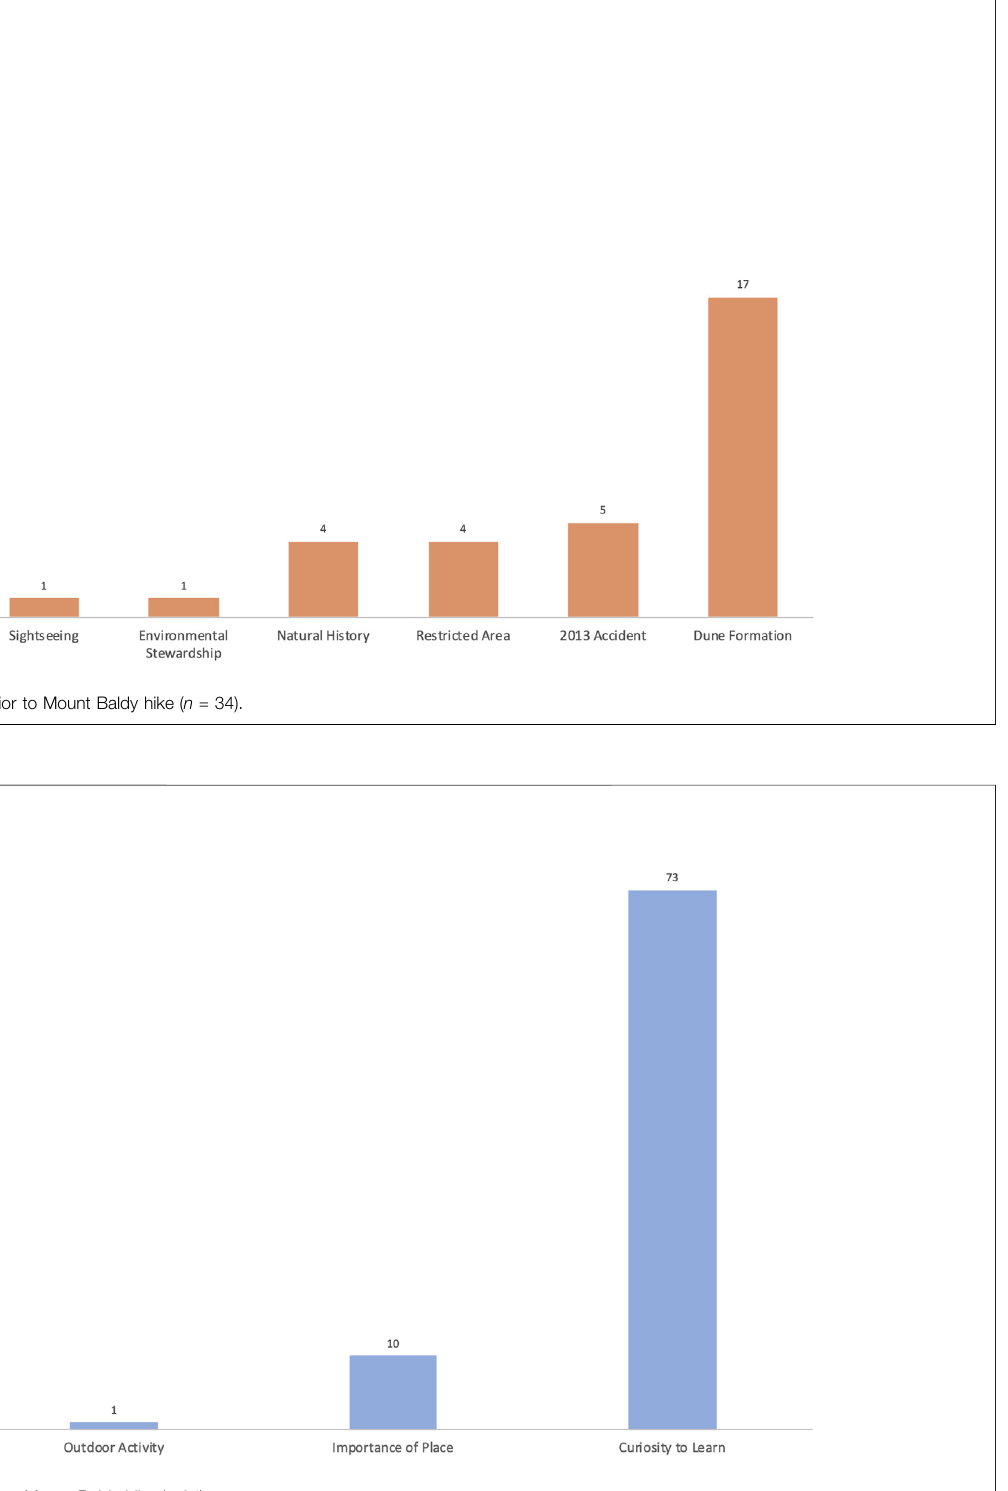
Frontiers in Education |